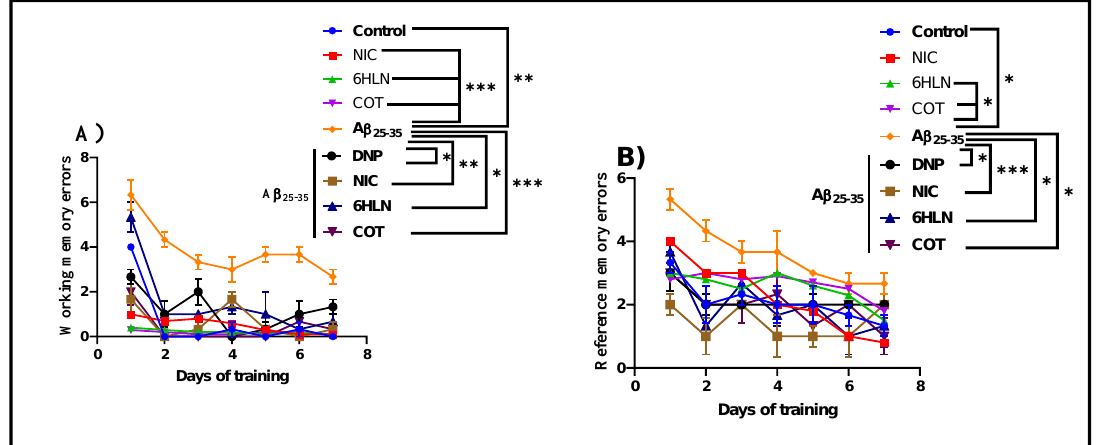
Figure 6. Effects of NIC, 6HLN and COT (0.3 mg/kg, b.w., i.p.) administration in Aβ 25-35 -treated rats on ( A ) working memory errors and ( B ) reference memory errors in RAM task. Values are expressed as means ± S.E.M. ( n = 6 animals per group). ANOVA analysis identified overall significant differences between experimental groups in ( A ) F(5.36) = 8.082, p < 0.0001 and ( B ) F(5.36) = 7.542, p < 0.0001. For Tukey post-hoc analyses—( A ) ** Control vs. Aβ 25-35 : p < 0.01; *** NIC vs. Aβ 25-35 , 6HLN vs. Aβ 25-35, COT vs. Aβ 25-35 : p < 0.0001; * Aβ 25-35 vs. DNP + Aβ 25-35 , Aβ 25-35 vs. 6HLN + Aβ 25-35 : p < 0.01; ** Aβ 25-35 vs. NIC + Aβ 25-35 : p < 0.001; *** Aβ 25-35 vs. COT + Aβ 25-35 : p < 0.0001; ( B ) * Control vs. Aβ 25-35 , 6HLN vs. Aβ 25-35 , COT vs. Aβ 25-35 : p < 0.01; * Aβ 25-35 vs. DNP + Aβ 25-35 , Aβ 25-35 vs. 6HLN + Aβ 25-35 ; Aβ 25-35 vs. COT + Aβ 25-35 : p < 0.01; *** Aβ 25-35 vs. NIC + Aβ 25-35 : p < 0.0001.